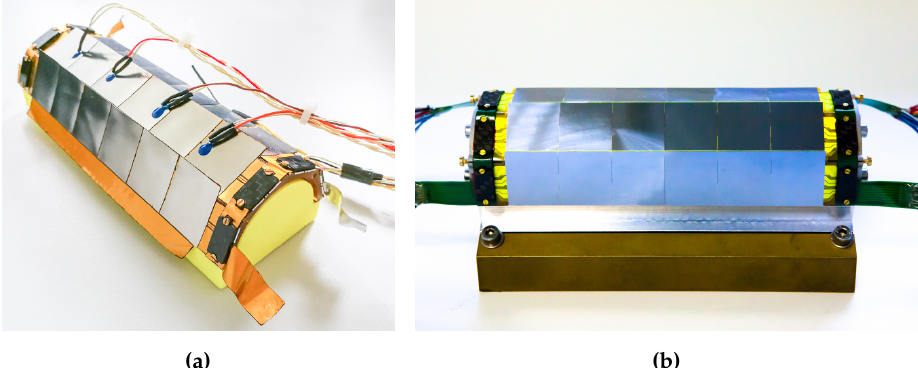
Figure 9. Pictures of inner layer thermo-mechanical mockup modules produced with ( a ) tape heaters and ( b ) silicon heaters